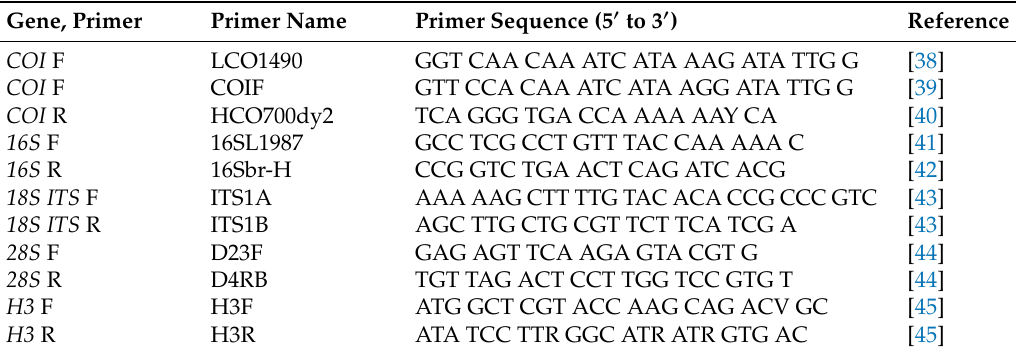
Table 2. PCR primers used for amplification of genetic markers screened in this study. Gene,